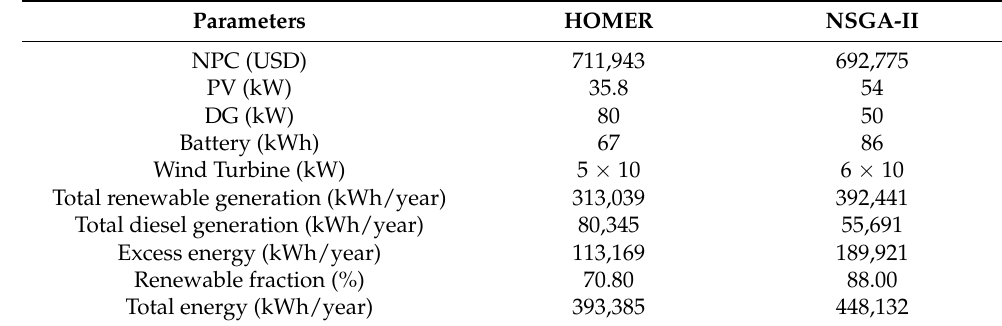
Table 10. Comparison between HOMER and NSGA-II for the proposed PV/Wind/Batterry/DG based